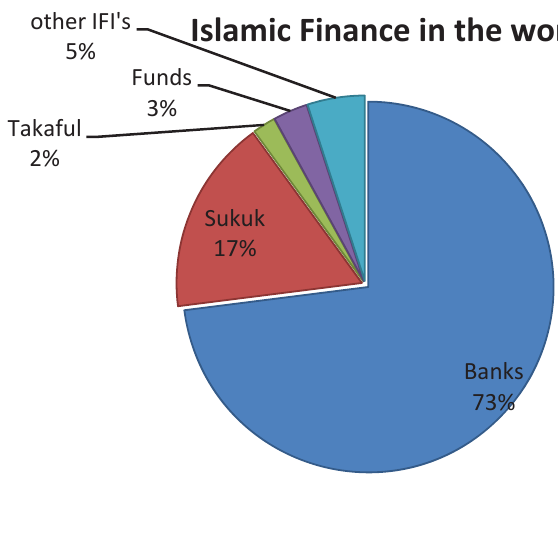
Fig. 4. Breakdown of Islamic finance into different